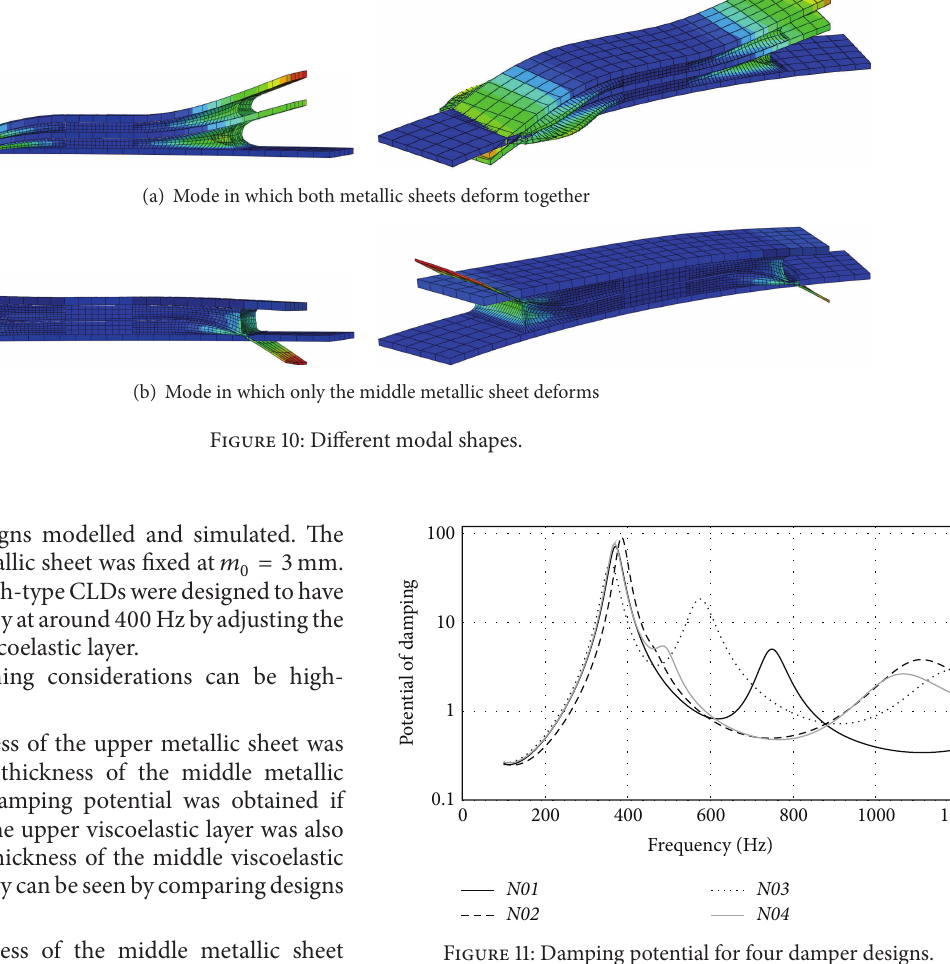
Figure 11: Damping potential for four damper